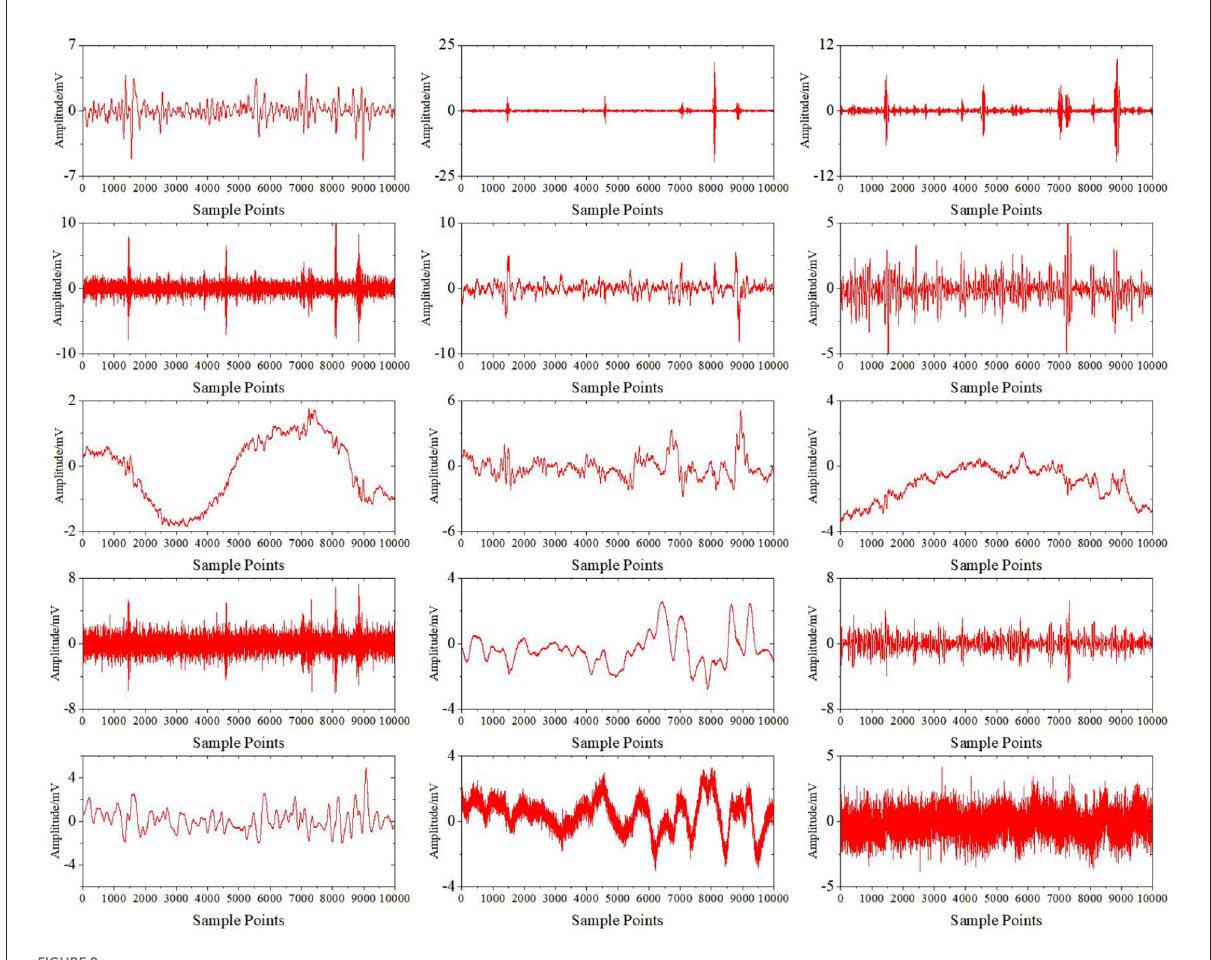
FIGURE8 ICA decomposition